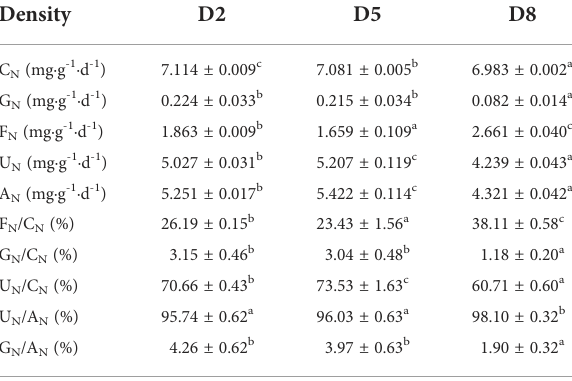
Data are mean ± S.D. and different letters in the same row represented signi fi cant differences at different stocking densities ( P < 0.05).